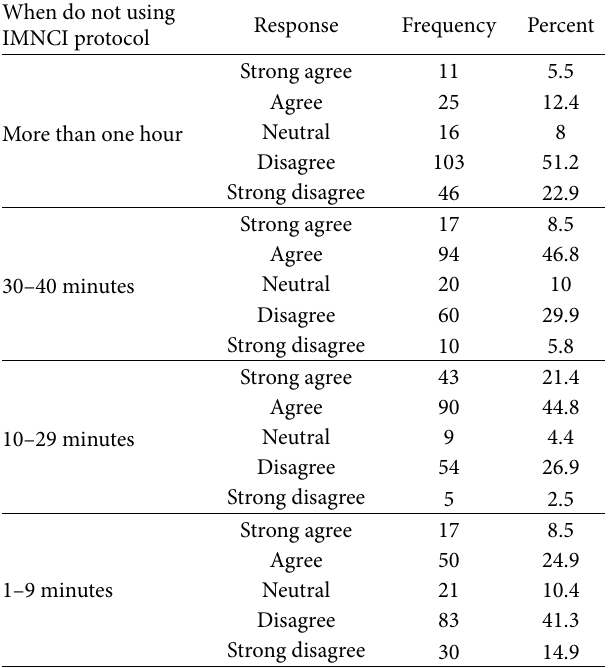
Table 10: Time spent managing an under-5 patient when not using the IMCI case management protocol. When do not using